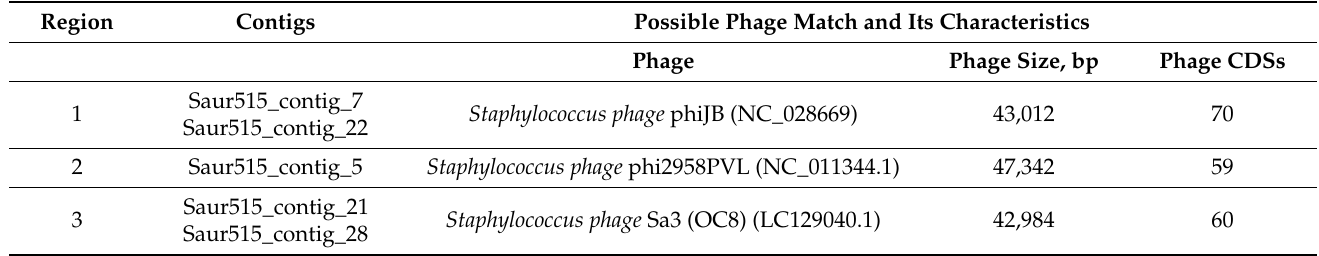
Table 1. Prediction of prophage regions in the S. aureus strain SA515 genome using PHASTER.